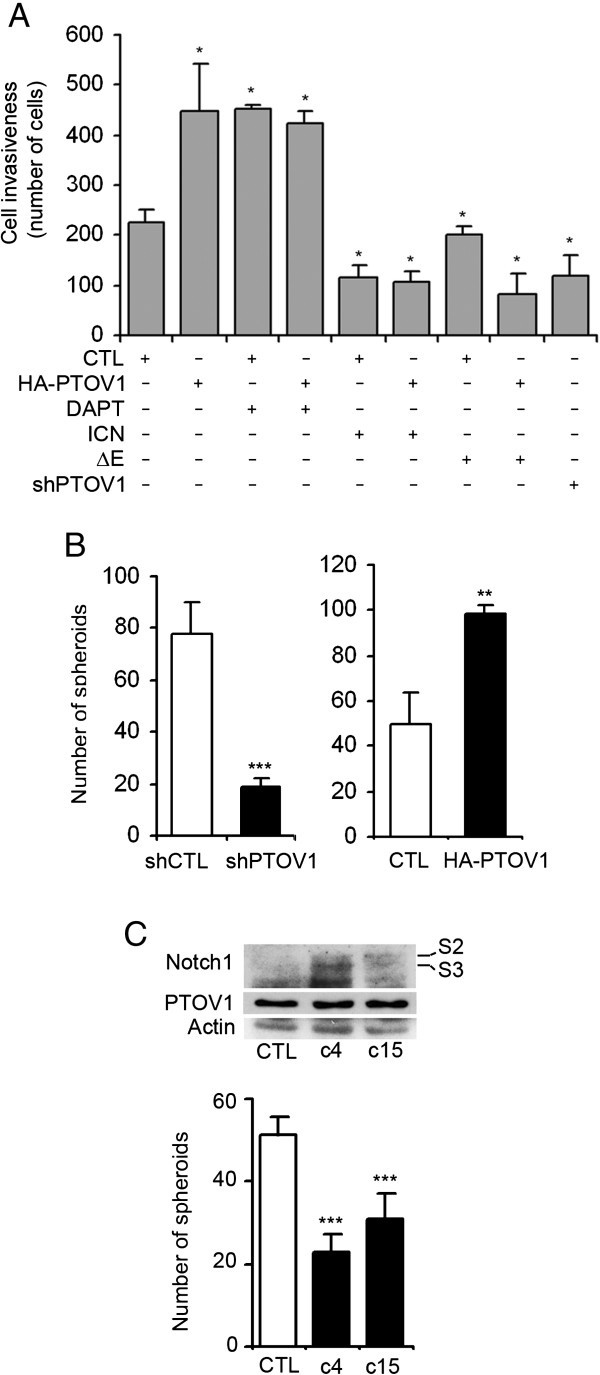
HA-PTOV1 overexpression promotes invasion and anchorage-independent growth of PC-3 cells in contrast to the effects of exogenous Notch1 expression. (A) PTOV1 induces in vitro cell invasion, in contrast to the inhibition caused by Notch1. PC-3 cells were transiently transfected with 5 μg of the indicated plasmids and/or 5μg of DNA carrier (CTL) and treated with DAPT or solvent for three days before trypsinization and plating on Matrigel-coated Transwell wells. After 24 h, invading cells were stained with Hoechst and scored. Short hairpin sh1397 was used to knockdown PTOV1 expression. Assays were performed in triplicate in at least two independent experiments. (B) PTOV1 promotes anchorage-independent growth of PC-3 cells. Cells stably knocked down for PTOV1 grew significantly fewer spheroids than control cells. In contrast, cells stably expressing HA-PTOV1 formed significantly more spheroids than cells transduced with control lentivirus. (C) Notch1 overexpression significantly decreases anchorage-independent growth of PC-3 cells. Independent clones c4 and c15, with stable expression of Notch1 as shown by Western blotting, formed significantly fewer spheroids than control cells transfected with control pcDNA3 vector. S2 and S3 indicate partial and active forms of Notch1 receptor. * p < 0.05, ** p < 0.005, *** p < 0.0005.